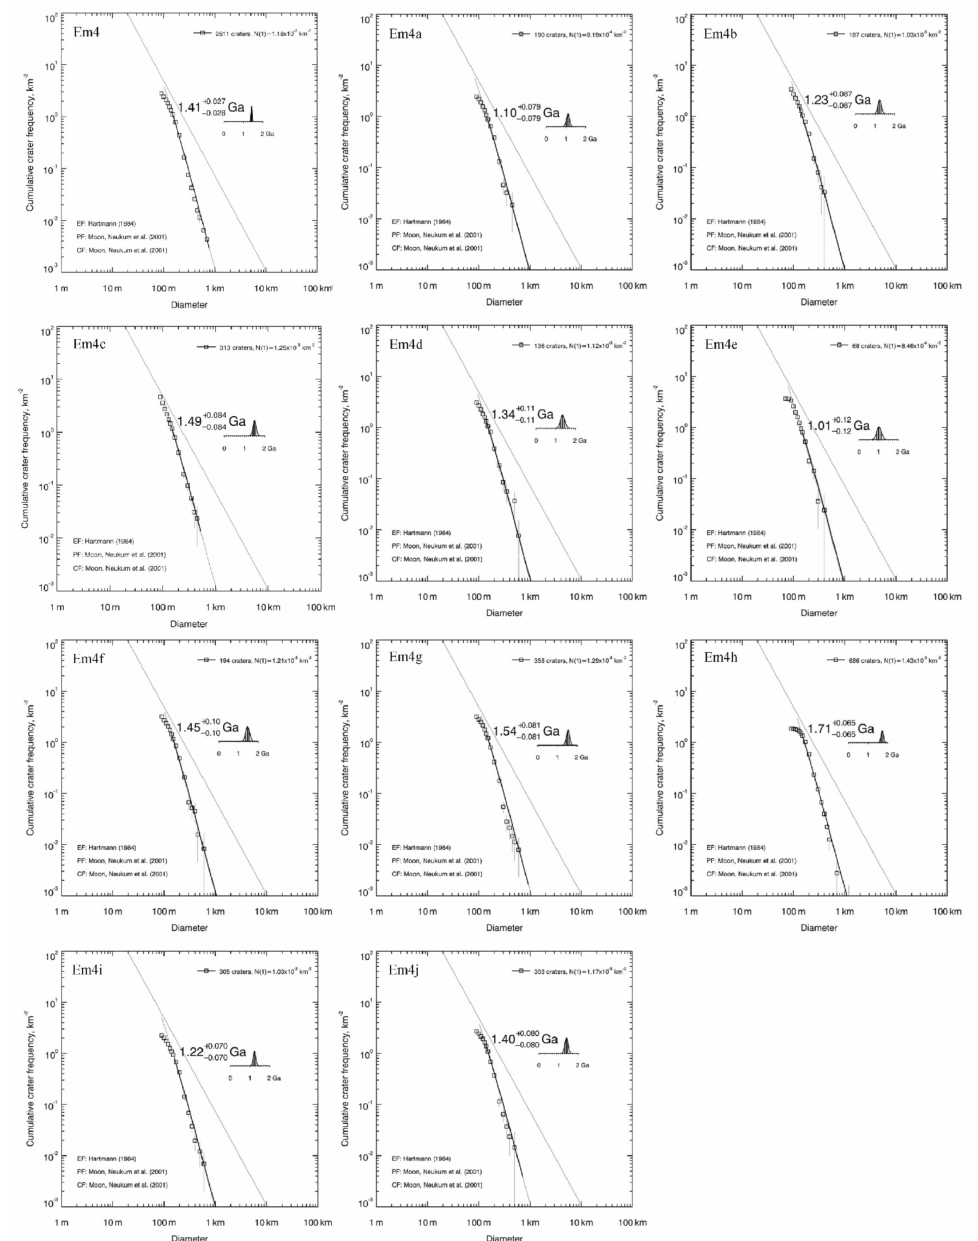
Figure 7. Crater size-frequency distributions, mean AMAs of Em4 and subunits Em4a–Em4j. The AMAs were determined using the Craterstats2 Tool [34] with the production and chronology func- tions of Neukum et al.